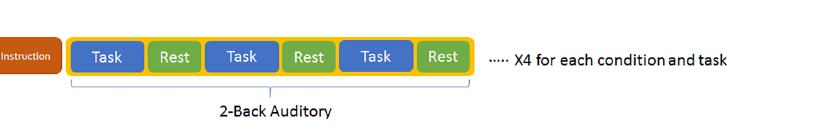
Fig 1. N-back working memory task for auditory and visual task for each 0-back and 2-back conditions. The task blocks were each 34-seconds long with the resting period of 15-seconds in